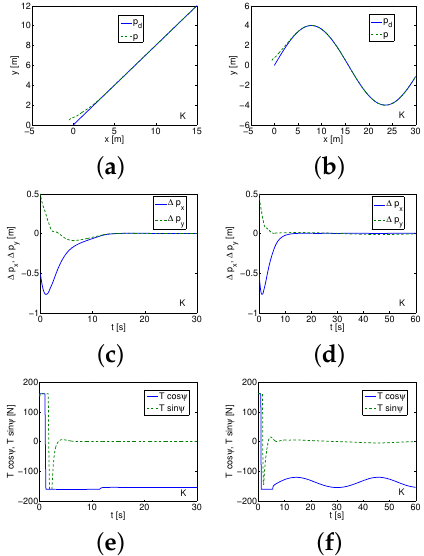
Figure 2. Simulation results for Kambara (Lyapunov method-based controller (MBC))—linear and sine trajectory. ( a , b ) Desired and realized trajectory; ( c , d ) position errors; ( e , f ) applied forces/torques.